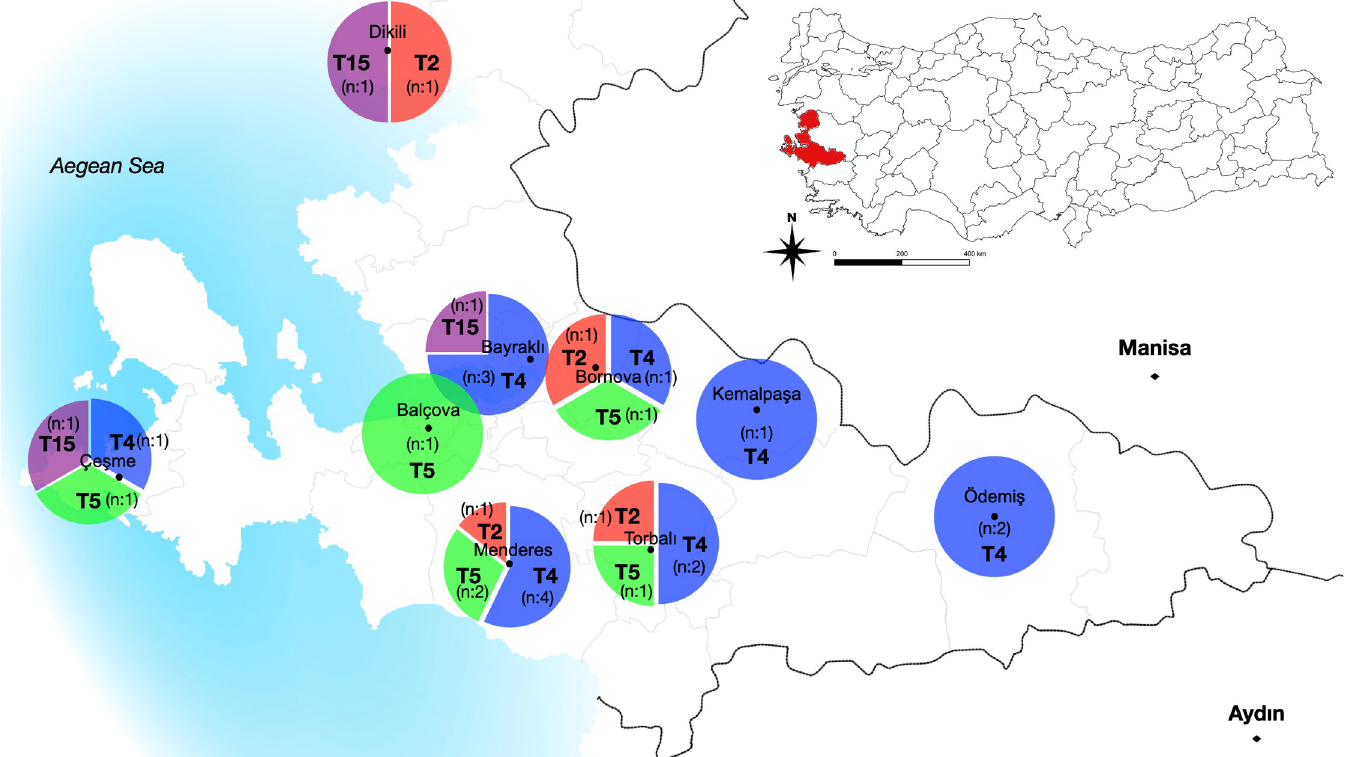
Fig 4. The distribution of Acanthamoeba genotypes according to different districts of İ zmir province and various water resources.